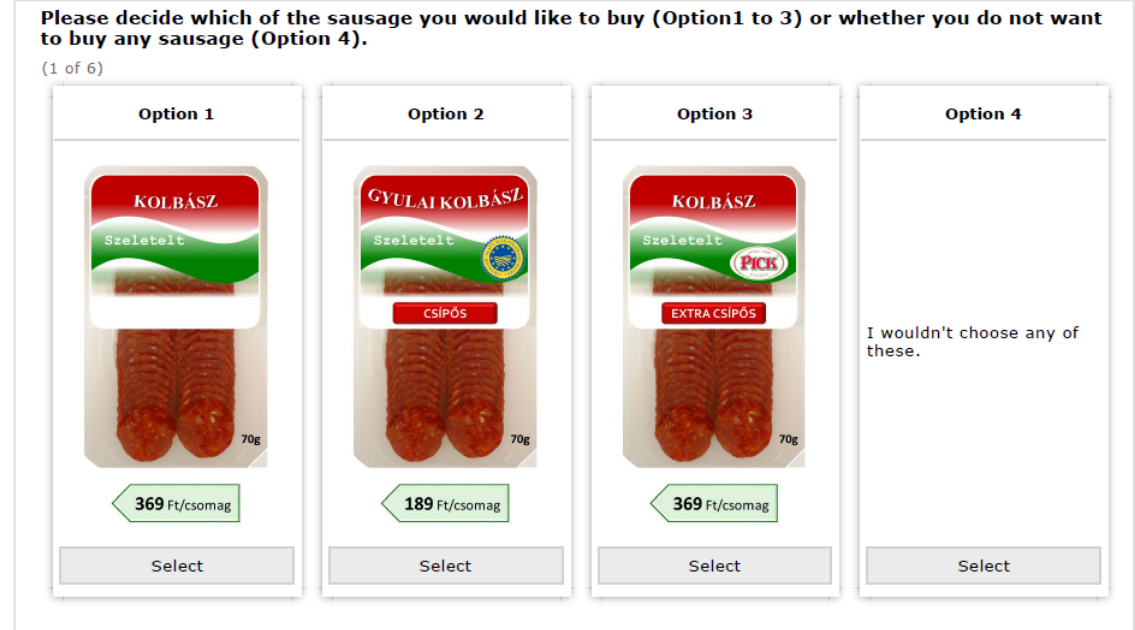
Figure 1. An example of a decision situation. Note: Option 1: sliced (‘Szeletelt’) sausage (‘Kolbász’), 369 HUF for a 70 g package (‘369 Ft/csomag’); Option 2: sliced Gyulai sausage (‘Gyulai kolbász’) with PGI label, spicy (‘Csíp ő s’), 189 HUF for a 70 g package; Option 3: sliced sausage with private brand label Pick, extra spicy (‘Extra csíp ő s’), 369 HUF for a 70 g package.